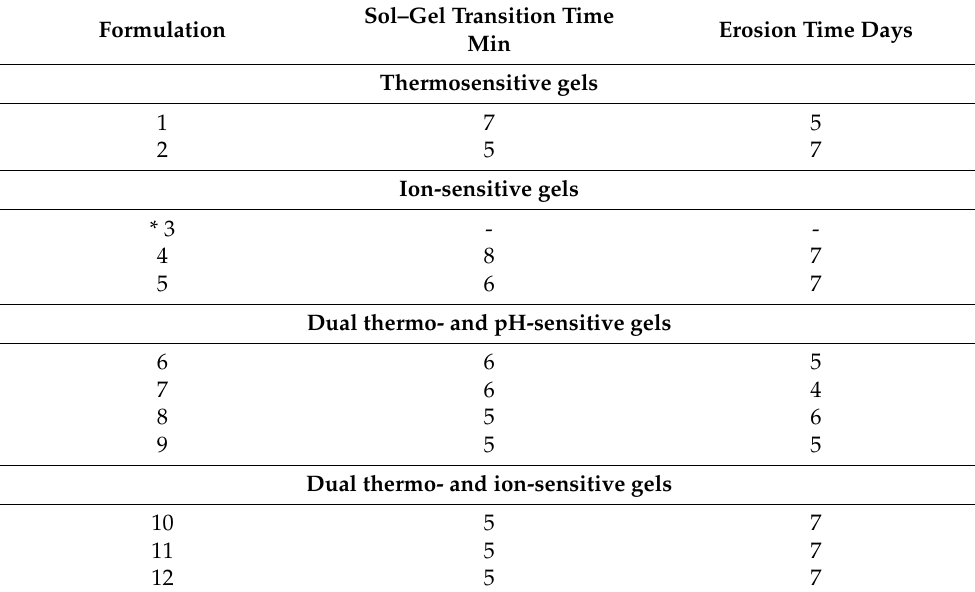
Table 5. Sol–gel transition and erosion time for 25% w/w Pluronic ® F127 (PF 127) gels.